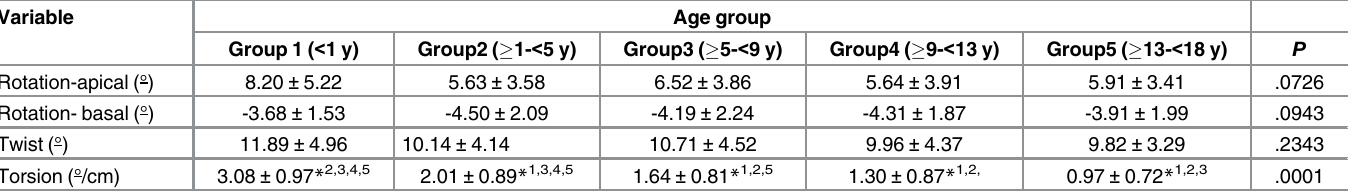
Table 3. Three-dimension LV rotation and torsion of study subjects.